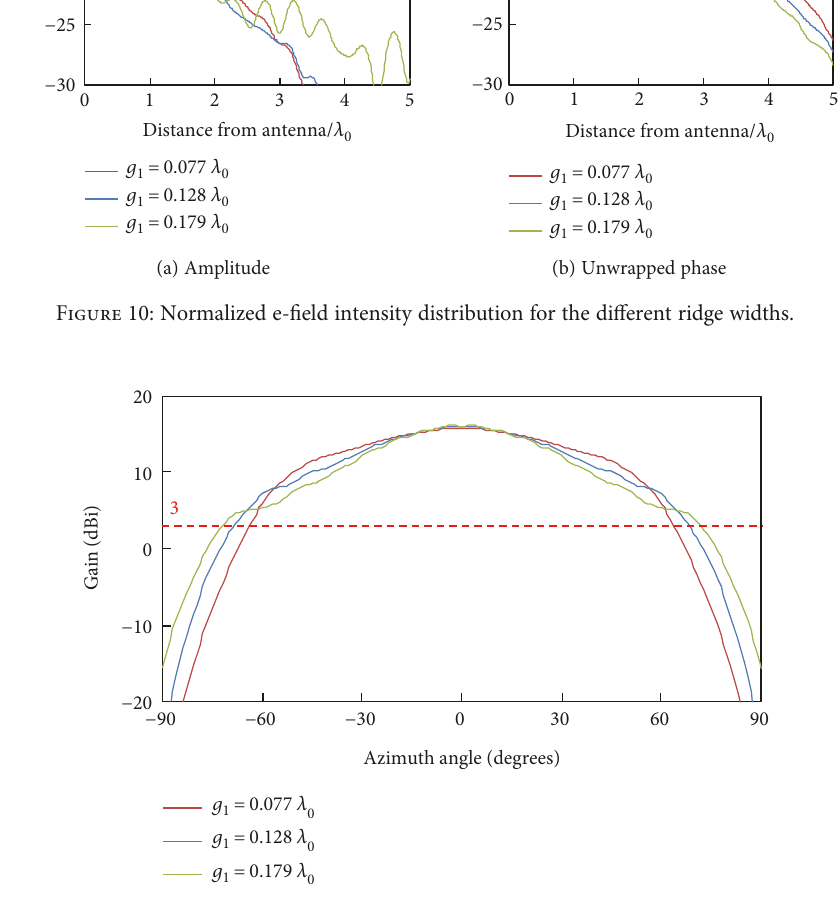
Figure 11: 3dBi beam width comparison for the di ff erent ridge widths. Table 3: 3dBi beam widths of the di ff erent ridge